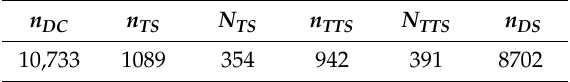
Table 1. The composition of the dataset used in the experimental work. DC , data collection; TS , training set; TTS , test set; DS , data set.